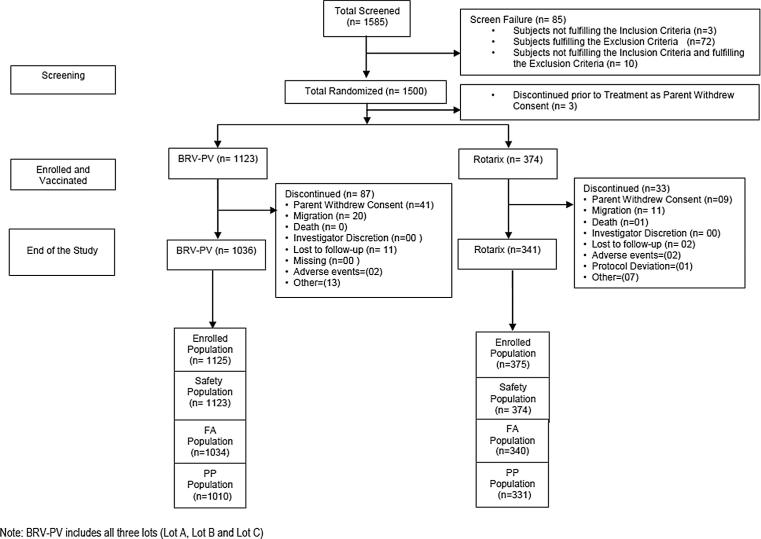
Study flowchart.